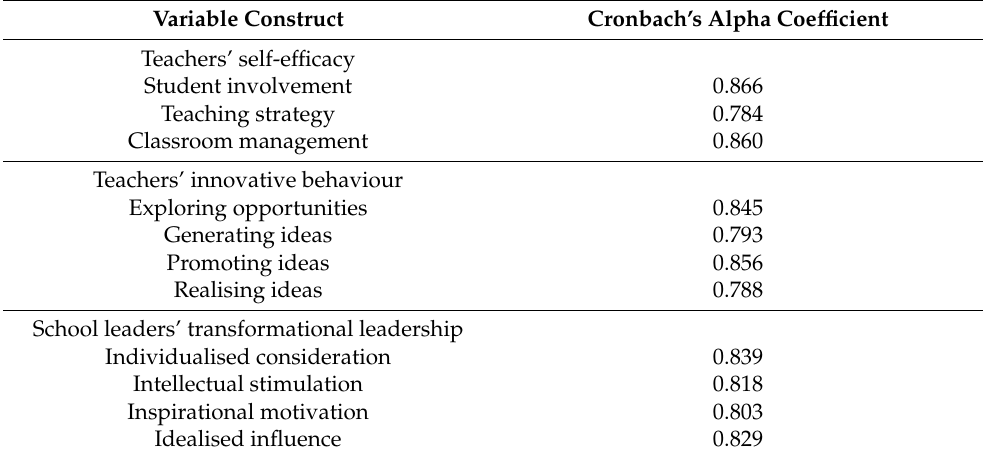
Table 13. Cronbach’s alpha coefficient by construct for all variables.